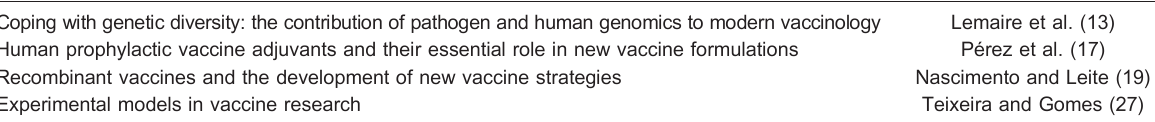
Table 1. Titles of Challenges in the Research and Development of New Human Vaccines. Coping with genetic diversity: the contribution of pathogen and human genomics to modern